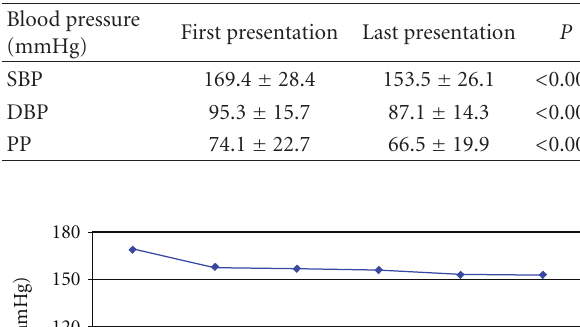
Table 2: Type of drugs used. Table 3: Change in blood pressure for all patients.